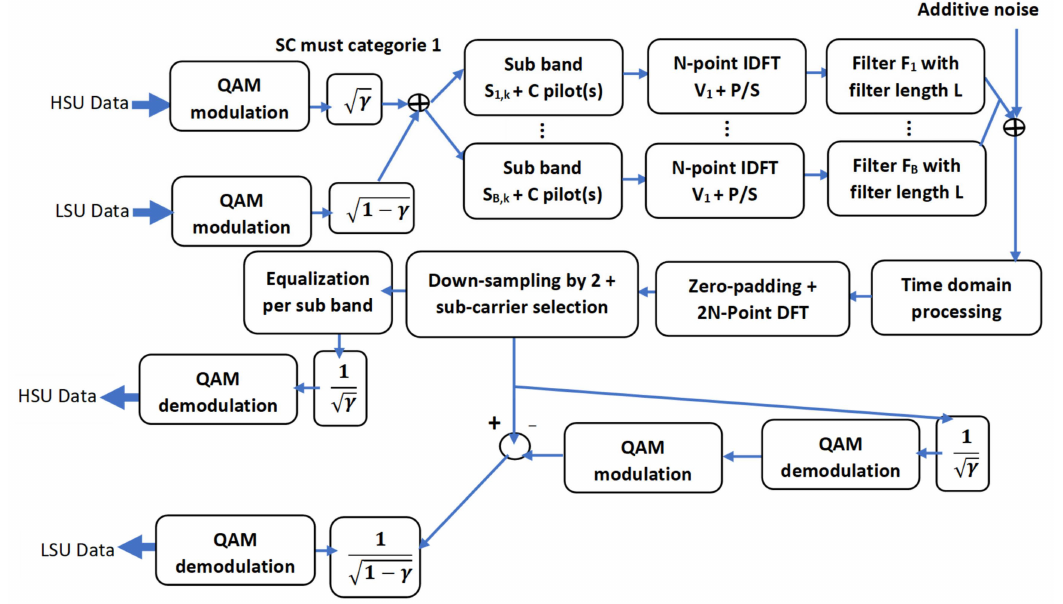
Figure 13. MIMO NOMORA system: P/S and S/P are abbreviations for parallel to serial and serial to parallel, respectively. F1, . . . , FB (this refers to the filter used for sub-band B) filter parameters depend on the users’